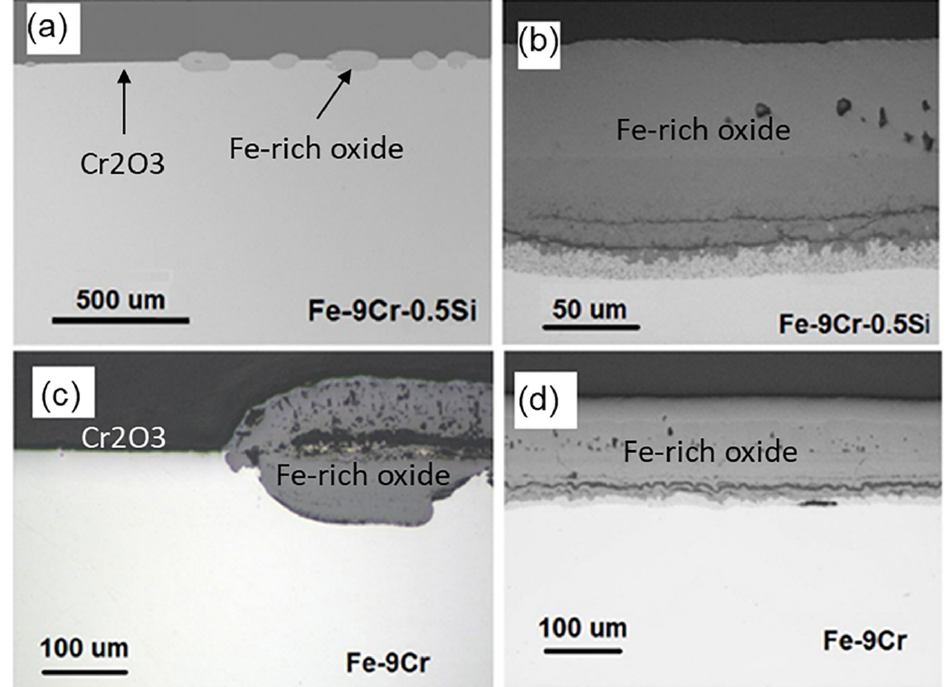
Figure 16. Cross-section overview of external scales for Fe9Cr and Fe9Cr0.5Si alloys exposed to Ar-20%CO 2 –20%H 2 O gas at 650 ◦ C/1 bar with and without SO 2 : ( a ) Fe9Cr0.5Si, 1.0%SO 2 , 240 h; ( b ) Fe9Cr0.5Si, no SO 2 , 240 h; ( c ) Fe9Cr, 1.0%SO 2 , 500 h; ( d ) Fe9Cr, no SO 2 , 240 h [95]. Reproduced with permission from